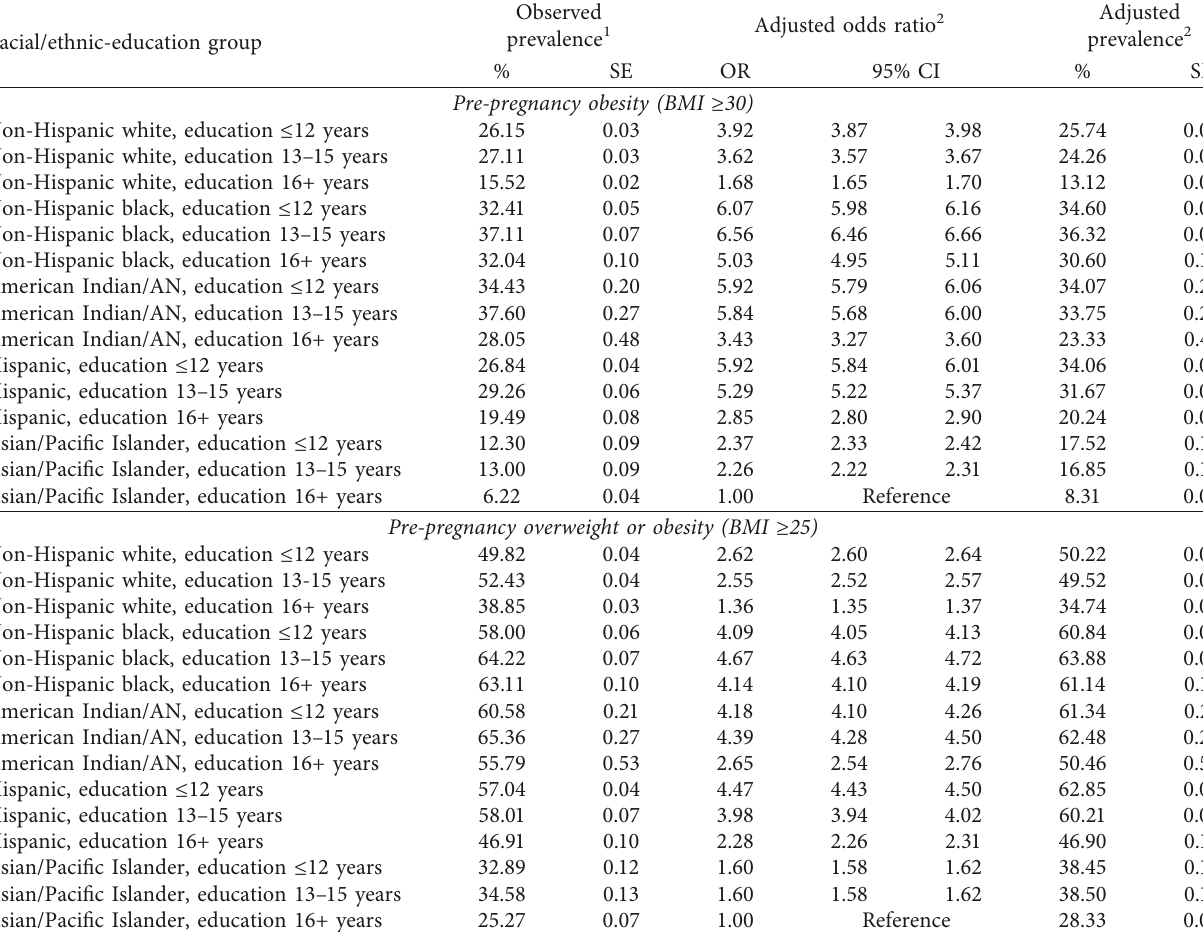
Table 6: Observed and adjusted prevalence and odds of pre-pregnancy obesity and overweight/obesity among women in 15 joint racial/ ethnic and education groups, United States, 2012-2014 ( N � 10 , 326 , 186) Racial/ethnic-education